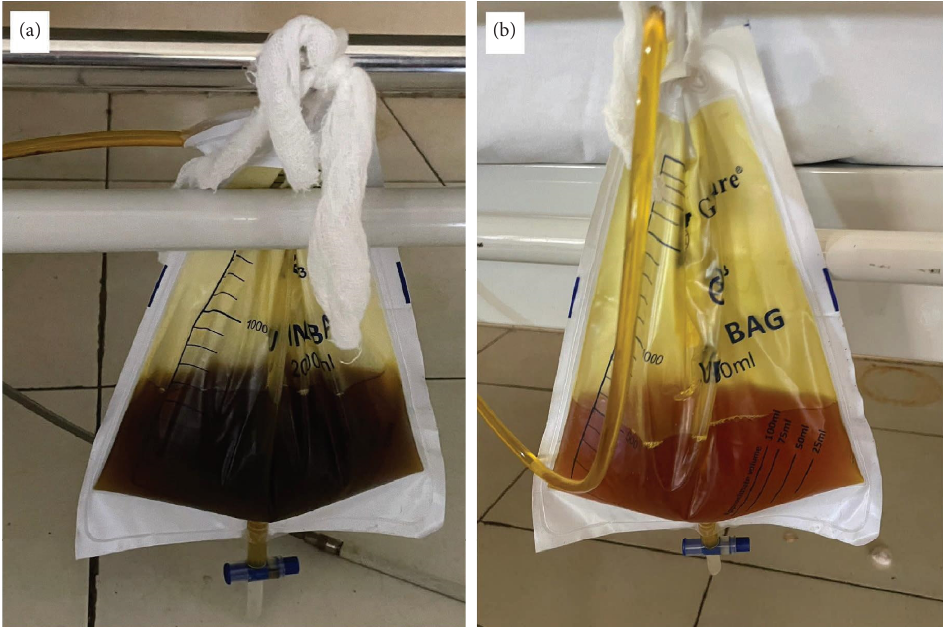
Figure 2: Urine collected on day 1 and day 3 since presentation legends. (a) Black-tea colored urine on day 1. (b) Yellowish-colored urine on day